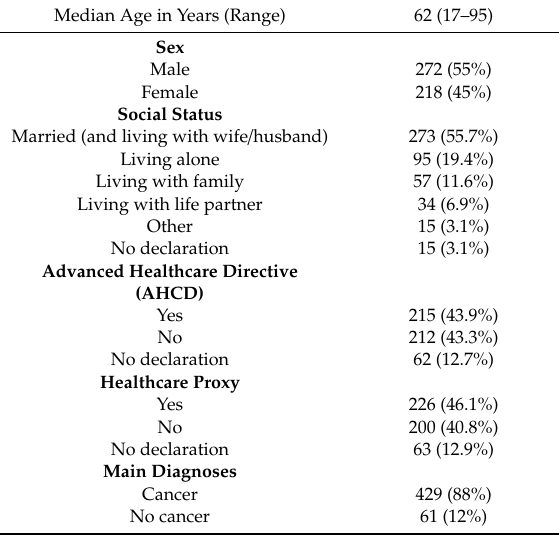
Table 1. Inpatient characteristics, main diagnoses, and Eastern Cooperative Oncology Group (ECOG) performance status of our subgroup analysis (for the first 13 months) ( n = 490).